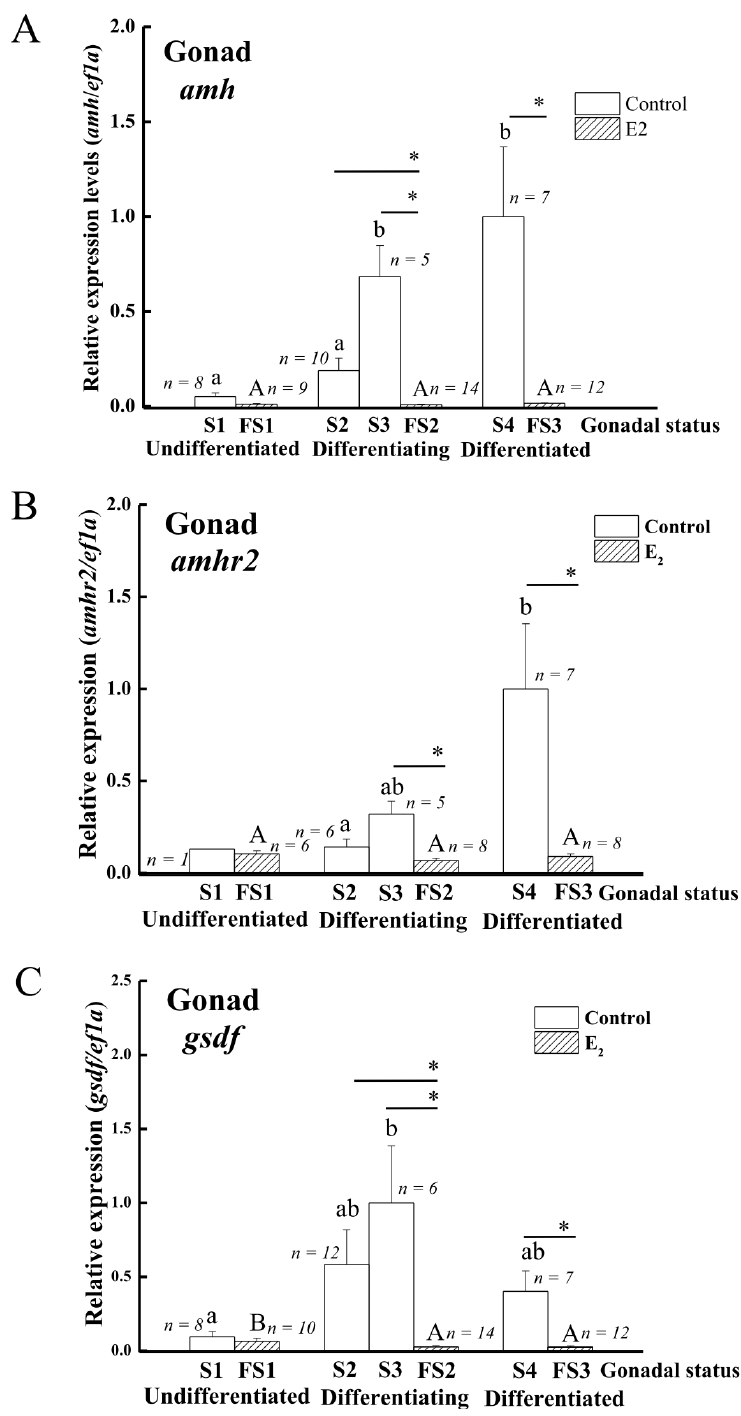
Figure 5. Expression profiles of sex-specific genes during sex differentiation in control and E2-induced feminized Japanese eels. ( A ) amh , ( B ) amhr2 , ( C ) gsdf . Transcripts were measured by qPCR. ef1a was used as an internal control gene. Data were expressed as means ± SEM. The number in the figure showed the fish number in each group. Small and capital letters indicate significant differences ( p < 0.05) among various gonadal status for the control groups and E2-induced feminized Japanese eels, respectively. Asterisks indicate significant differences (* p < 0.05) between the control eels and E2-induced feminized Japanese eels. For the control eels, S1, undifferentiated gonad; S2, early differentiating gonad; S3, late differentiating gonad; S4, differentiated testis. For the E2-induced eels, FS1, undifferentiated gonad (E2 treated group); FS2, differentiating ovary; FS3, differentiated